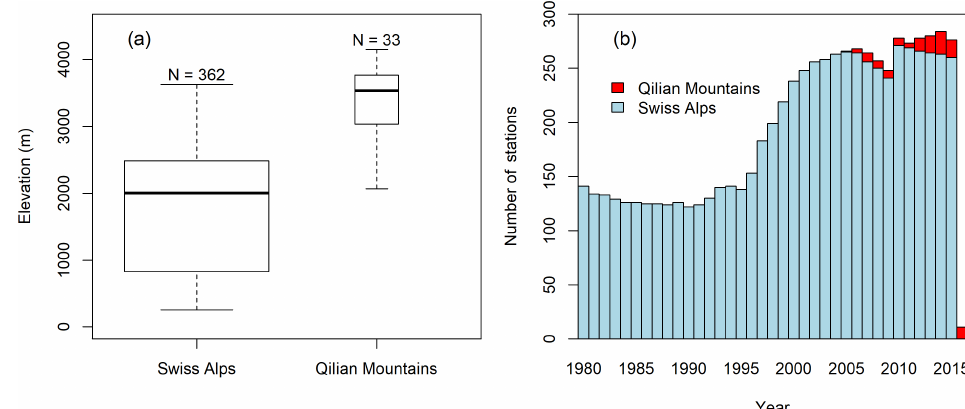
Figure 2. Elevation distribution of observation station (a) and number of observation stations ( N ) used in different years (b)